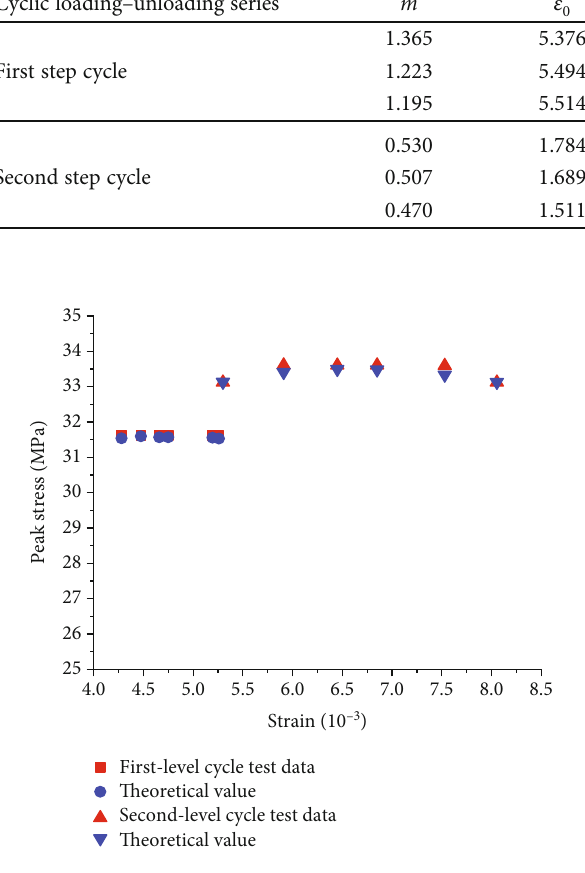
Figure 15: Comparison between experimental data and theoretical